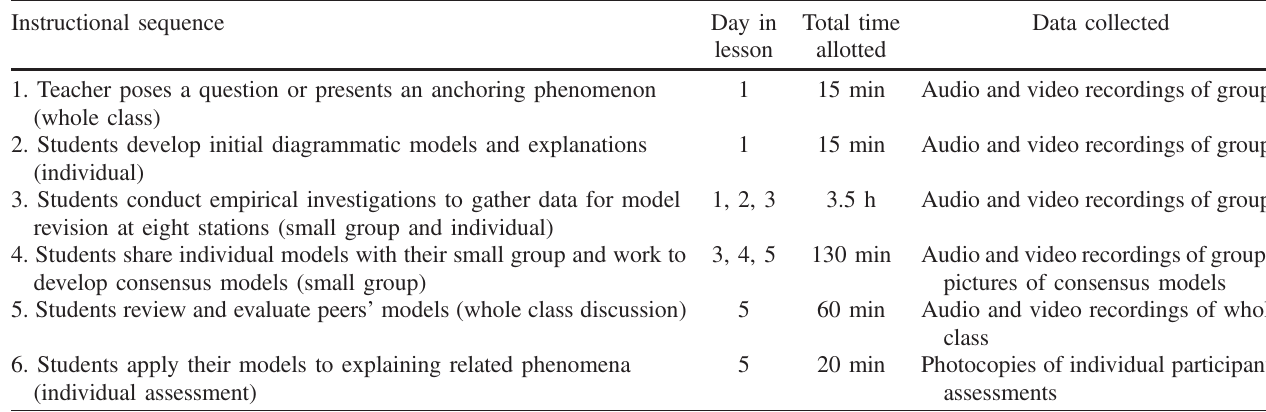
TABLE I. Overview of instructional design steps in the lesson, time allocated to each step, and research data collected. The final discussion, which was a focus of the current analysis, occurred in step 5. Instructional